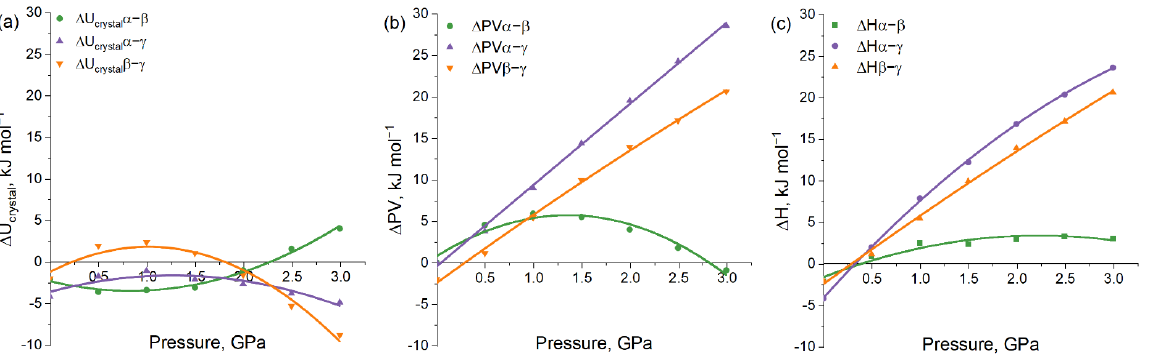
Figure 5. Calculated ( a ) lattice energy ΔU crystal , ( b ) ΔPV term and ( c ) ΔH differences between p -Tol 2 S 2 polymorphs α and γ (green), α and β (purple), β and γ (orange) as a function of pressure (i.e. , ΔUα – β = Uα − Uβ, ΔPVα – β = PVα − PVβ, ΔHα – β = Hα − Hβ, etc.). Phase transition between the involved polymorphs can be expected when their enthalpy difference is equal to zero.